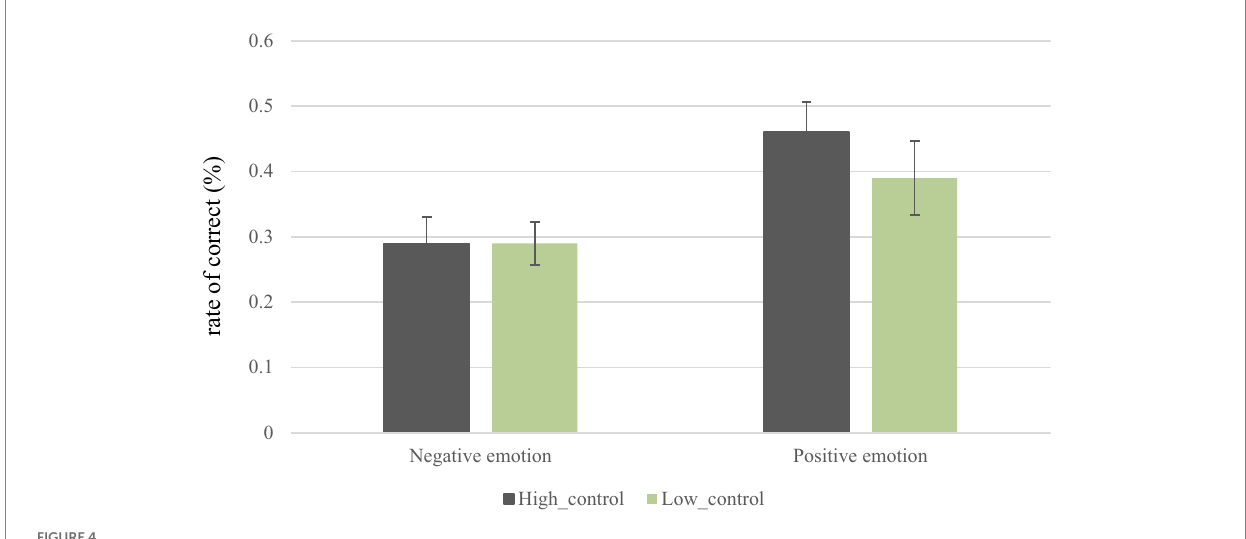
FIGURE 4 Correct rate of cognitive reflection test (CRT) between high/low level of metacognitive control ability groups and emotion manipulation in Experiment